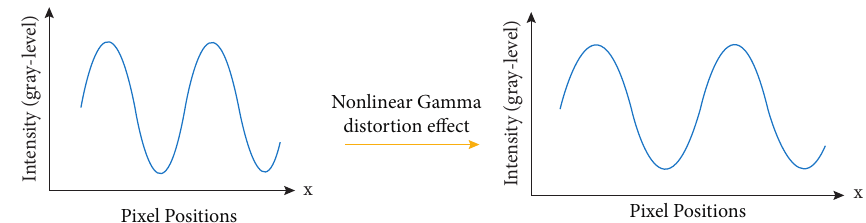
Figure 1: The schematic diagram of the distortion gamma sinusoidal